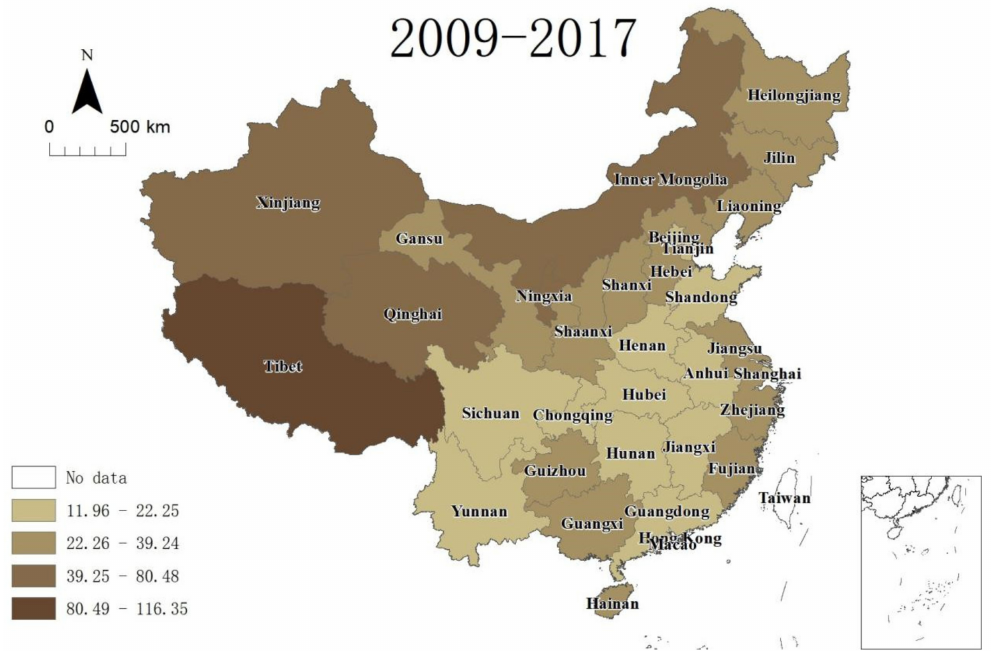
Figure 5. Average PCTLA values in 31 Chinese provinces in km 2 /person (2009–2017). Data source: China Land and Resources Statistical Yearbook (2015–2017) [29] and NBSC (2022)